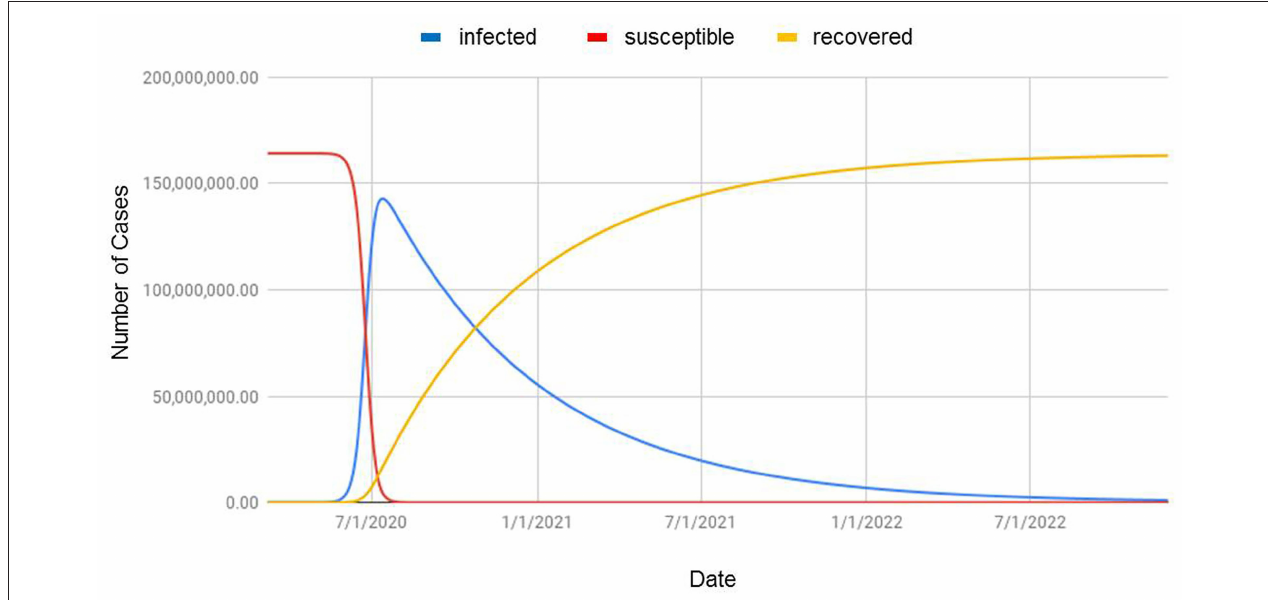
FIGURE 9 | Prediction of COVID-19 situation based on the SIR model applied to populations in Bangladesh (infected = confirmed cases; susceptible = population at risk; recovered = cumulative cured or dead COVID-19